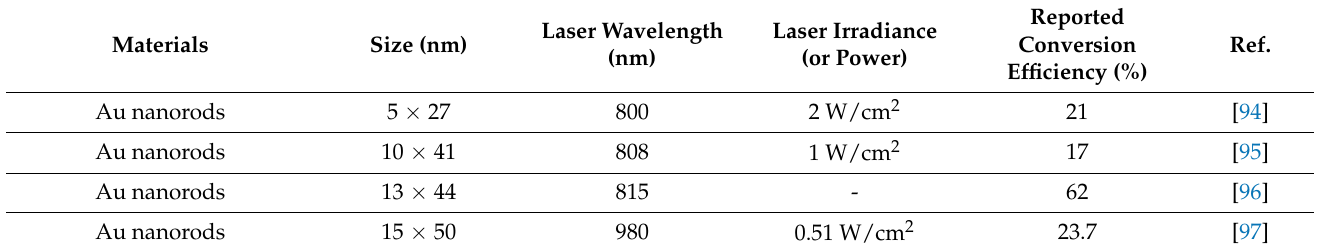
Table 2. Photothermal conversion efficiency of different